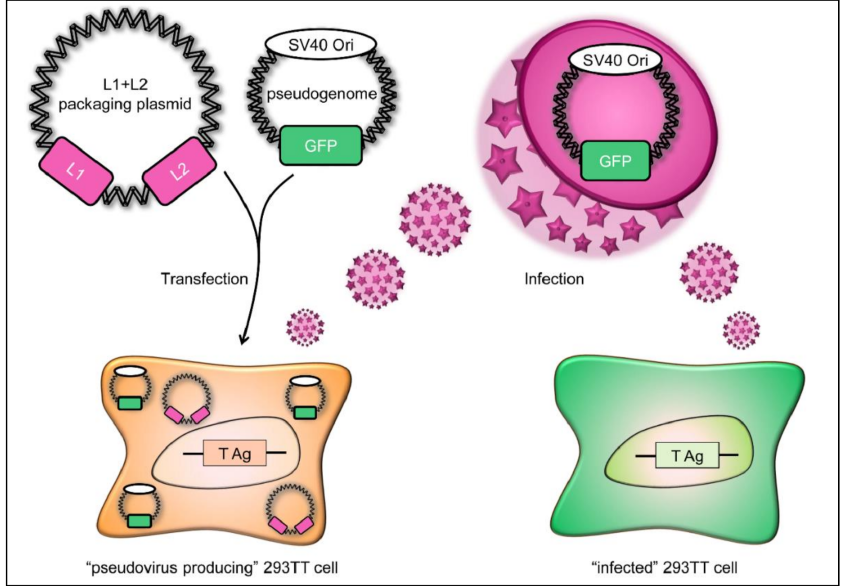
Figure 1. Schematic diagram of HPV16 pseudovirus production. The packaging plasmid encoding the L1 and L2 capsid proteins (pink) is transfected into 293TT cells along with a pseudogenome encoding the green fluorescent protein (GFP; shown in green), resulting in “pseudovirus-producing” 293TT cells. The pseudogenome carries a SV40 origin of replication (SV40 Ori), allowing high expression in 293TT cells. These cells synthesize L1 and L2 capsids that assemble into virus particles carrying the pseudogenome. These pseudoviruses can then be used to infect 293TT cells, which in turn express GFP encoded by the pseudogenome, which can then be visualized under a microscope, as shown in Figure 2.